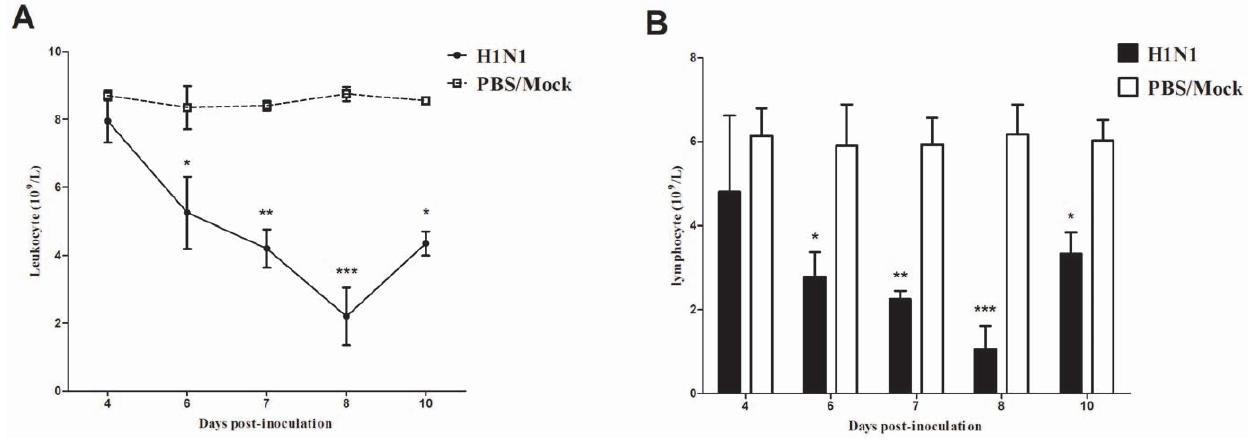
Figure 4. Kinetic analysis of circulating leukocytes (A) and lymphocyte (B) following SD/09 virus infection. Peripheral blood samples were collected at indicated times p.i. The total number of leukocytes and differential blood counts for three individual mice were analyzed. *p , 0.05 **, p , 0.01, ***p , 0.001, comparison between virus-infected and control groups. doi:10.1371/journal.pone.0029347.g004 PLoS ONE |